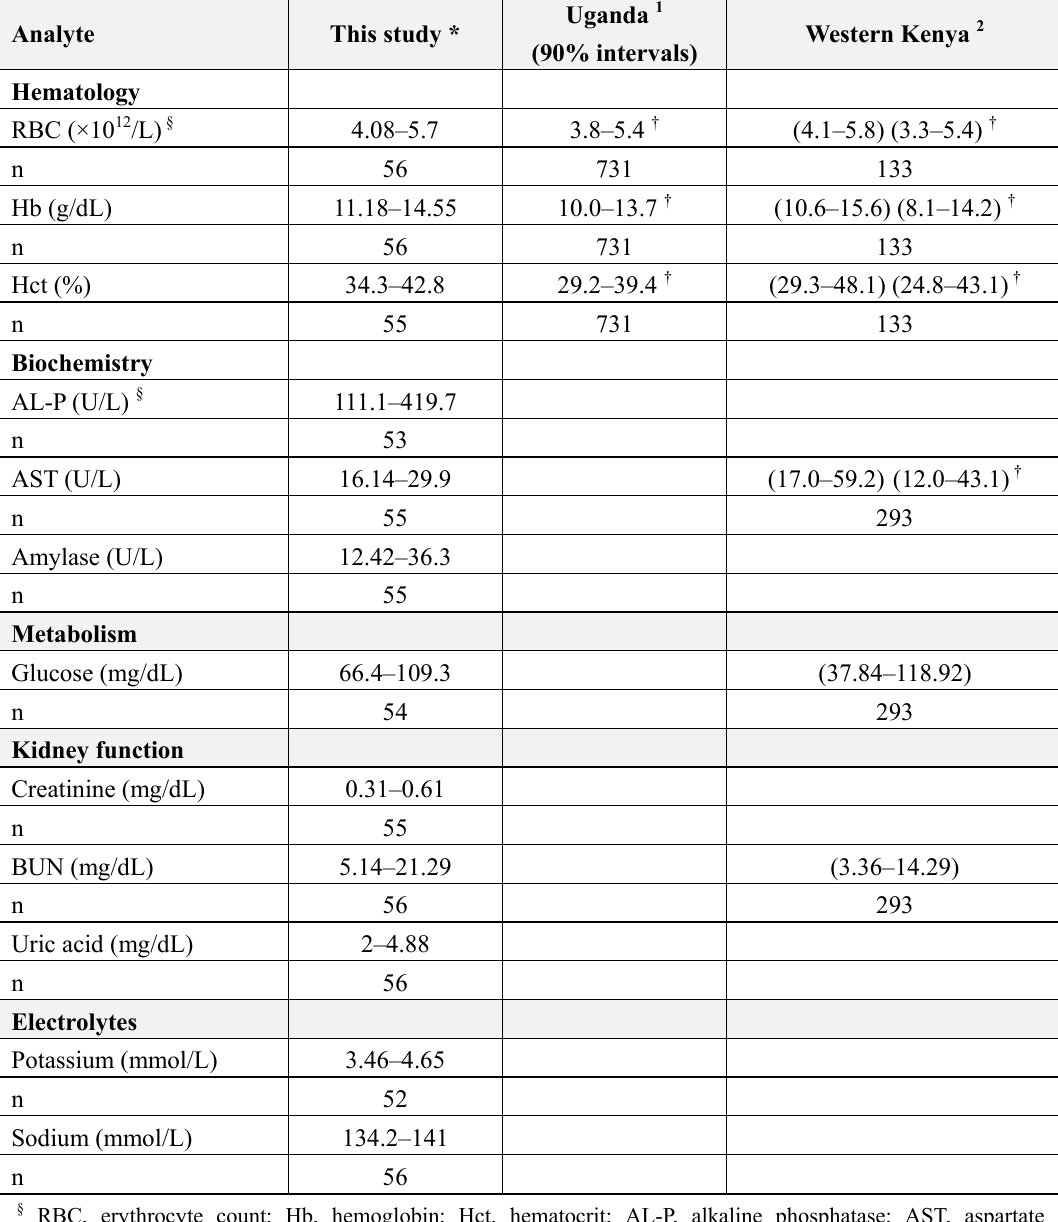
Table 6. Comparison of hematology and biochemistry ranges with other studies in Africa: 6–15